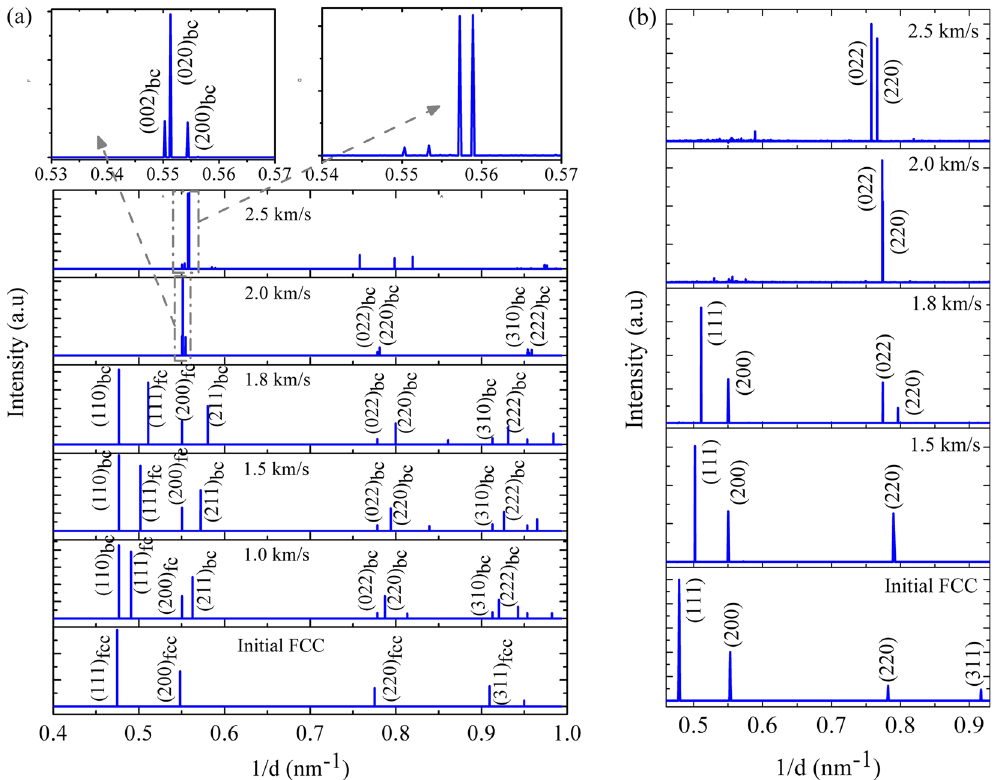
Figure 7. X-ray diffraction patterns of Cu along 〈 110 〉 crystallographic direction at ambient temperature and pressure as well as shock compressed conditions at different piston velocities demonstrating structural phase transition: ( a ) Results obtained from classical MD simulations (which includes both NEMD and MSST simulations) ( b ) Results obtained from ab − initio MD